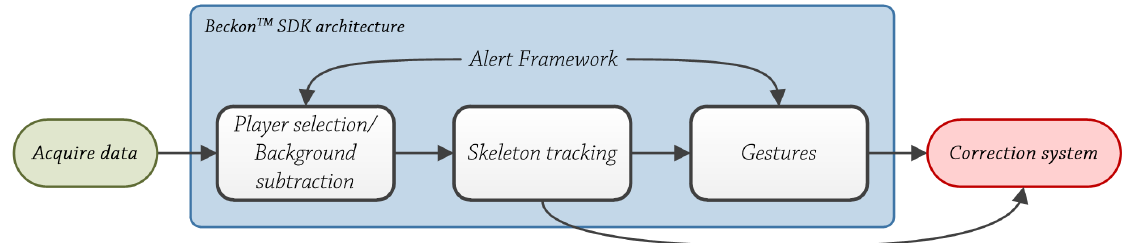
Figure 5. Beckon™ SDK